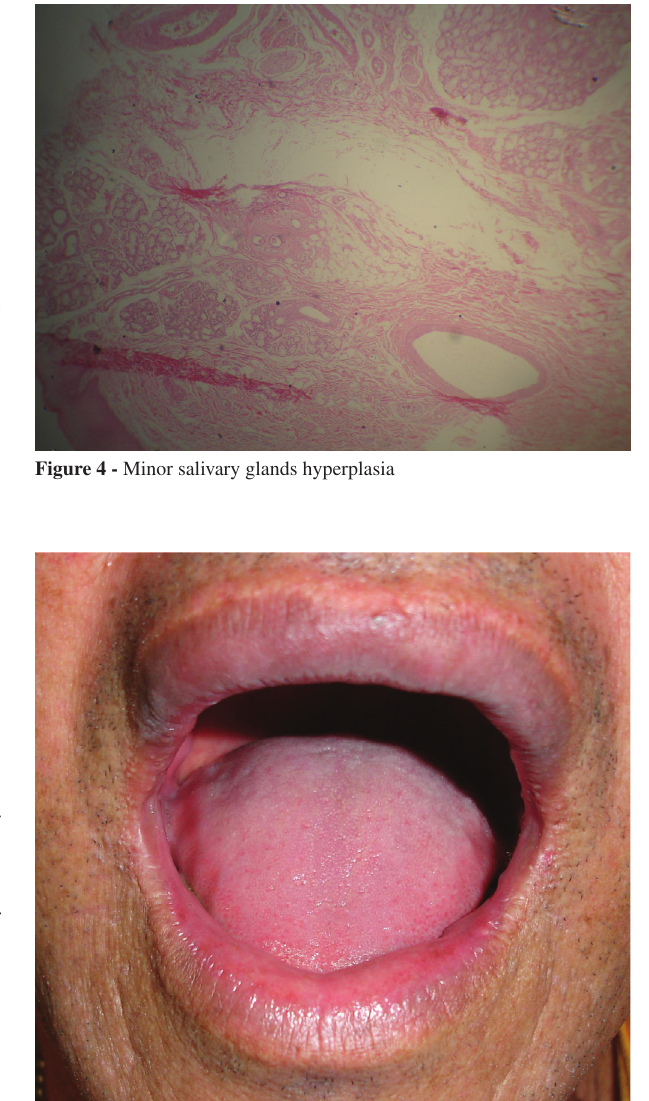
Figure 5 - Cosmetic results